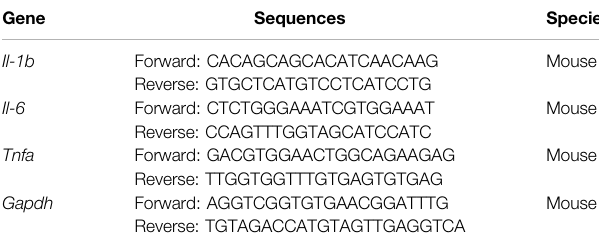
TABLE 1 | Primer for real-time RT-PCR was used in this